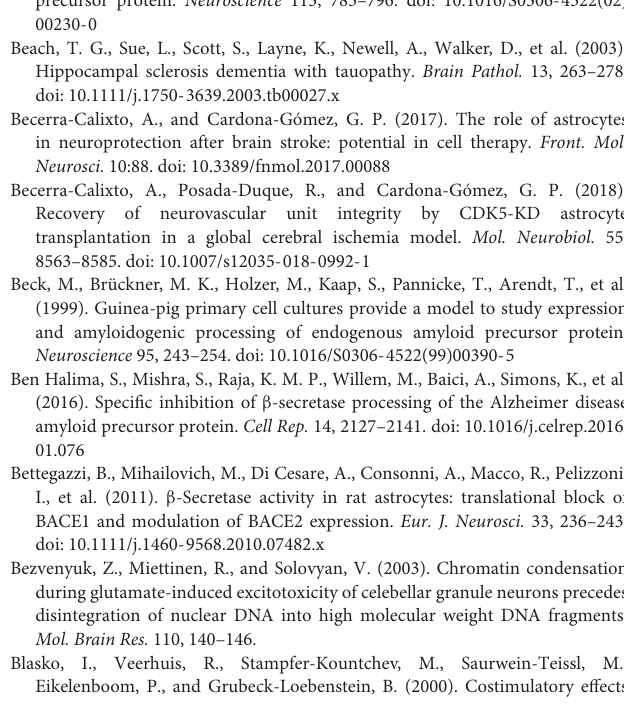
Supplementary Figure 1 | BACE1, Phospho-tau, GFAP and CLDN5 immunoreactivities in subiculum area of dementia brains (A) Representative image of the subiculum from a human control case. Magnification: 10 × . Scale bar: 25 µ m. (B) Representative images of the BACE1, (C) Phospho-tau, (D) GFAP, and (E) CLDN5 immunoreactivities in subiculum area of human hippocampal tissue. Magnification: 10 × . Scale bar: 50 µ m. Inset: 25 µ m scale bar. The values in the bar graph are expressed as a densitometric percentage of the BACE1 IR in the CA1 area. FAD: familial-type Alzheimer’s disease (presenilin 1 mutation E280A); SAD: sporadic Alzheimer’s disease; CADASIL: autosomal dominant cerebral arteriopathy with subcortical infarcts and leukoencephalopathy. The data are expressed as the means ± SEM. n = 4. * p < 0.05; ** p < 0.01. Supplementary Figure 2 | BACE1, Phospho-tau, GFAP and CLDN5 immunoreactivities in the CA4 area from demented cases (A) Representative image of area CA4 in the hippocampus from a control case. Magnification: 10 × . Scale bar: 25 µ m. (B) Representative images of the BACE1, (C) Phospho-tau, (D) GFAP, and (E) CLDN5 immunoreactivities in the CA4 area of human hippocampal tissue. Magnification: 10 × . Scale bar: 50 µ m. Inset: 25 µ m scale bar. The values in the bar graph are expressed as a densitometric percentage of the BACE1 IR in the CA1 area. FAD: familial-type Alzheimer’s disease (presenilin 1 mutation E280A); SAD: sporadic Alzheimer’s disease; CADASIL: autosomal dominant cerebral arteriopathy with subcortical infarcts and leukoencephalopathy. The data are expressed as the means ± SEM. n = 4. * p < 0.05; **** p < 0.0001. Supplementary Figure 3 | Cytotoxicity of BACE1 inhibitor at different concentrations. Percentage of LDH released by ECs of the bEnd.3 cell line at BACE1 inhibitor concentrations of 1, 5, 7.5, and 10 µ M. The data are presented as the mean of n = 3, and the experiment was performed in duplicate. Control = inhibitor vehicle